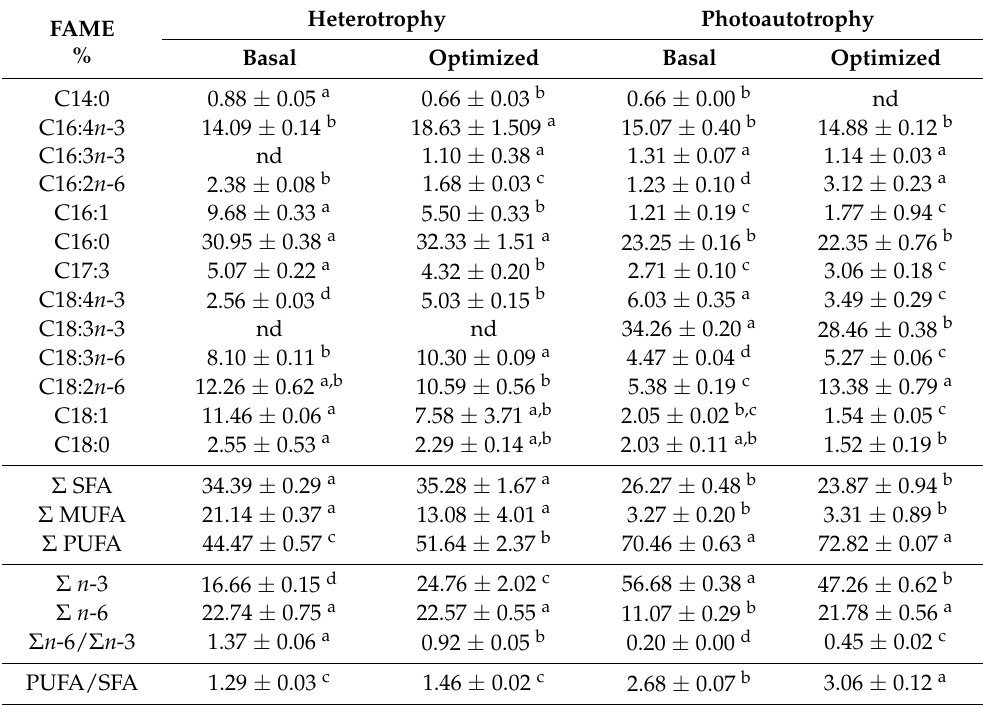
Table 9. Fatty acid methyl esters (FAME) profile; presented in percentage of total fatty acids of Chlorococcum amblystomatis biomass grown with hetero- and photoautotrophic basal and optimized media. Different letters indicate significant differences between media. Values are given as mean ± standard deviation ( n =